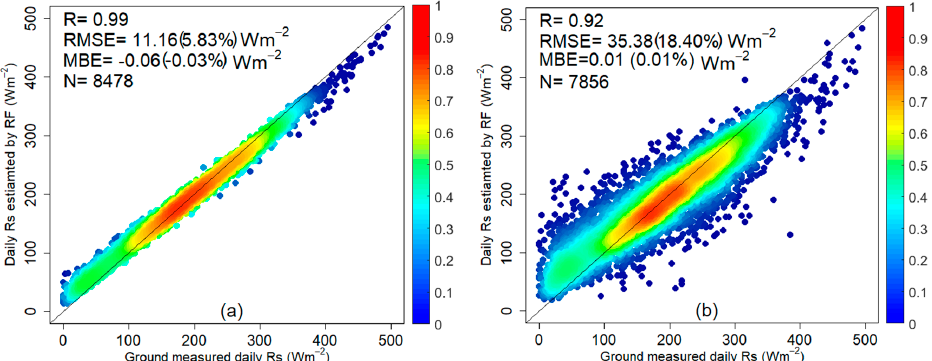
Figure 6. Evaluation results of daily estimated R S data from Himawari-8 AHI data based on the RF method against ground measurements from CDC/CMA from February to May 2016: ( a ) for training data; ( b ) for validation data. Estimated R S data are averaged from a 58 km × 58 km window centered at the stations. N is the number of data